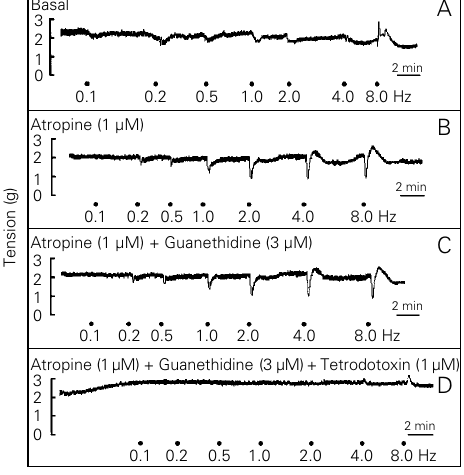
Figure 4 - Relationship between the magnitude of EFS-induced NANC relaxations of isolated lower esophageal sphincter (filled circles) and ileocolonic junction (open circles) strips. Ten-second trains of pulses (0.5 ms and 40 V) were applied at 2- min intervals at different fre- quencies. Data are reported as the mean ± SEM (N = 8). All experiments were performed in the presence of 1 µM atropine and 3 µM guanethidine which were added 20 min before stim- ulation. The relaxation magni- tude is reported as % of that obtained with sodium nitroprus- side